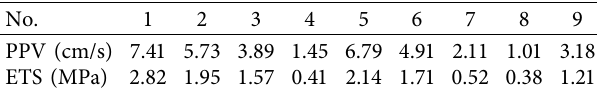
Table 10: Values of ETS and PPV from numerical simulations.